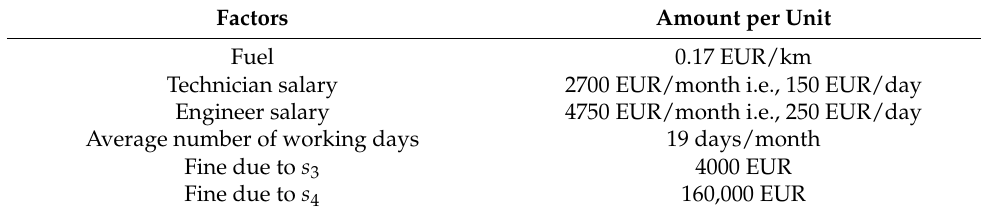
Table 2. Unit amounts of different factors of payoffs.